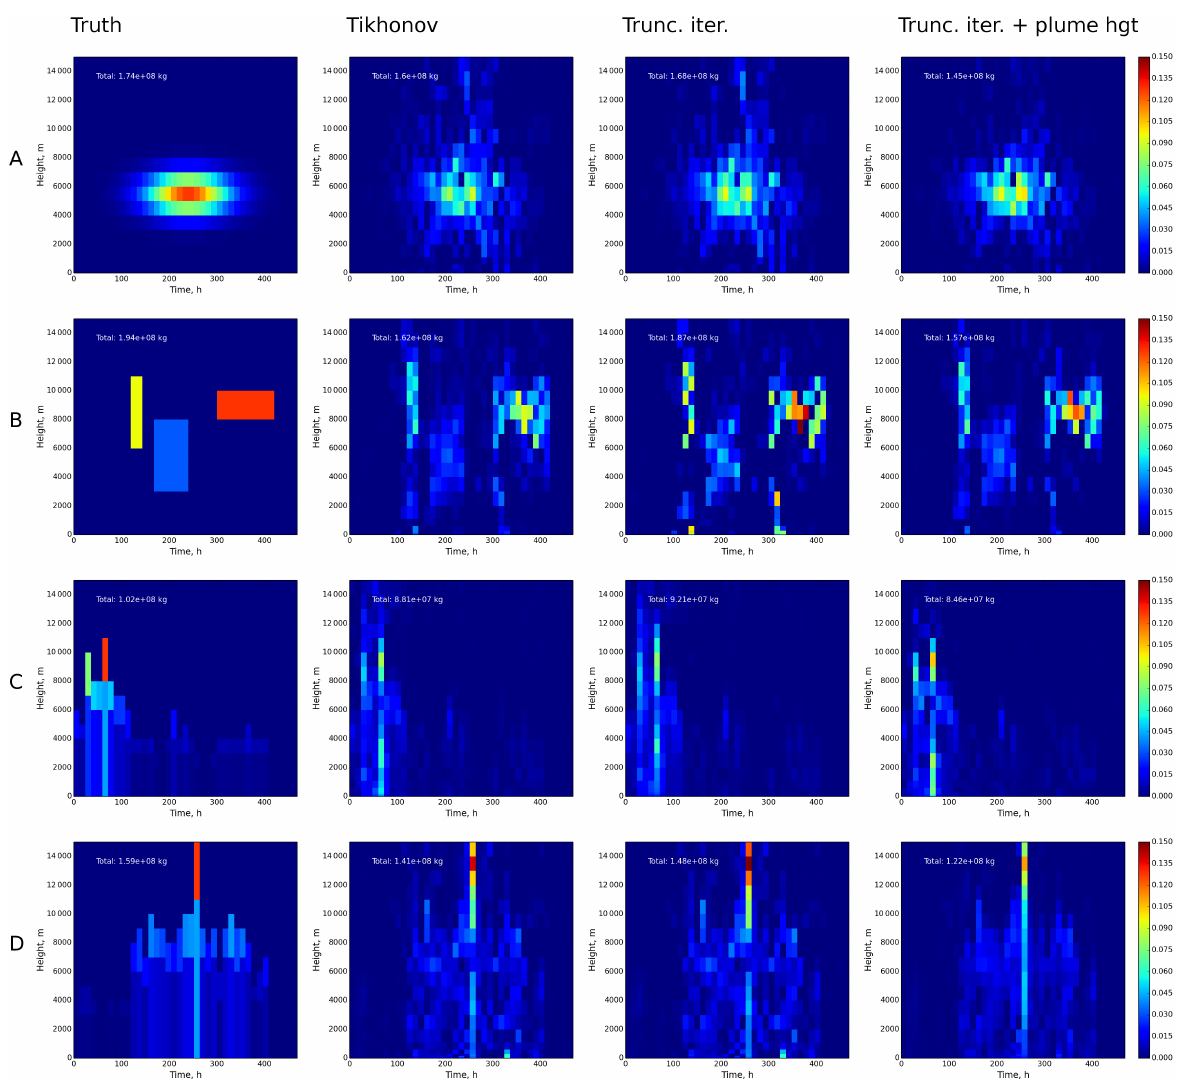
Figure 1. Estimated emission flux (kgm − 1 s − 1 ) in source term inversions with simulated data. True source terms for the four cases (A to D) are shown in the left column. The remaining columns show the inversion results using Tikhonov regularization, using truncated iteration with total column data and using truncated iteration with total column and plume height